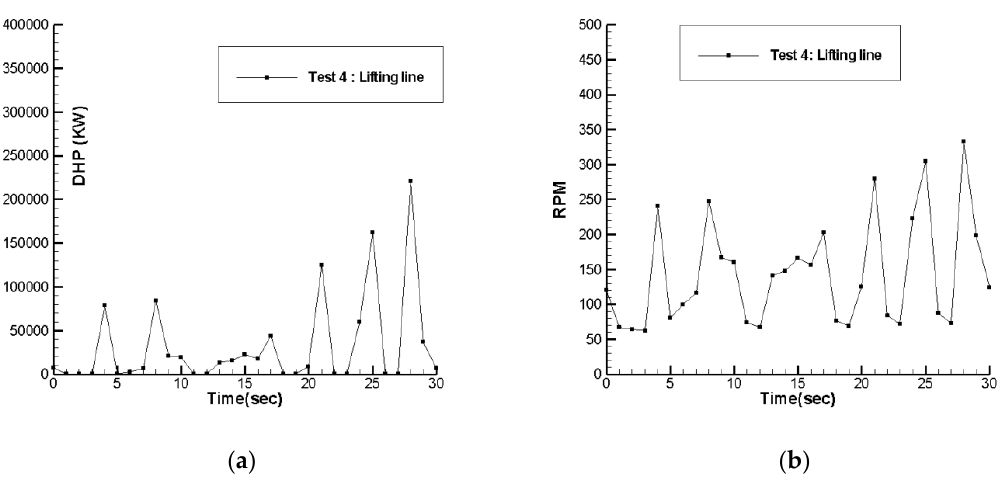
Figure 31. Time history of the required DHP ( a ) and RPM ( b ), numerical experiment #4.